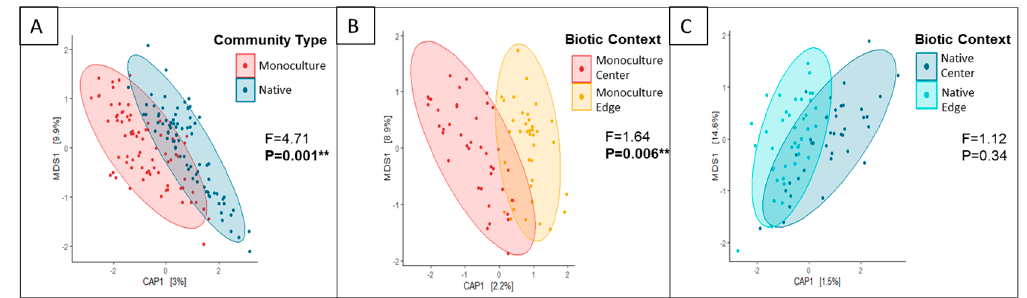
Figure 1. Constrained ordinations showing the effect of community type and biotic context on fungal root composition. Each point represents the root endosphere of an individual plant. Ellipses represent a 95% confident interval for each group. Endosphere composition differed significantly between the monoculture and native community types ( A ). Endosphere composition also differed between the center and edge biotic contexts within the monoculture community ( B ). There was no difference in endosphere composition between the center and edge biotic contexts within the native community ( C ). P -values less than 0.1 are highlighted in bold and labeled with the following notation: † p < 0.1, * p < 0.05, ** p < 0.01, *** p < 0.001.